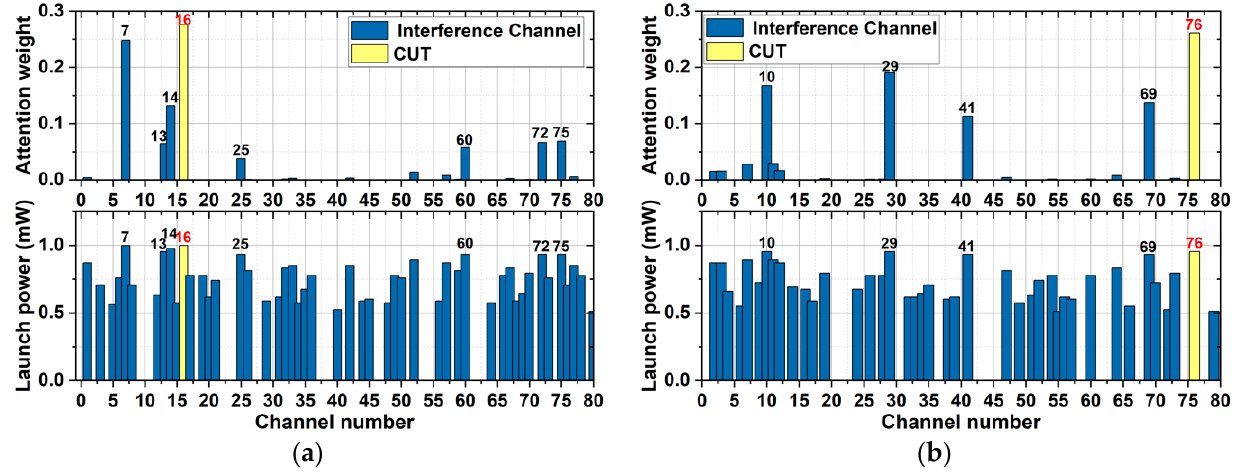
Figure 6. ( a ) Attention weight and launch power of each channel for Ch_16 in the Jnet; ( b ) attention weight and launch power of each channel for Ch_76 in the NSFnet.